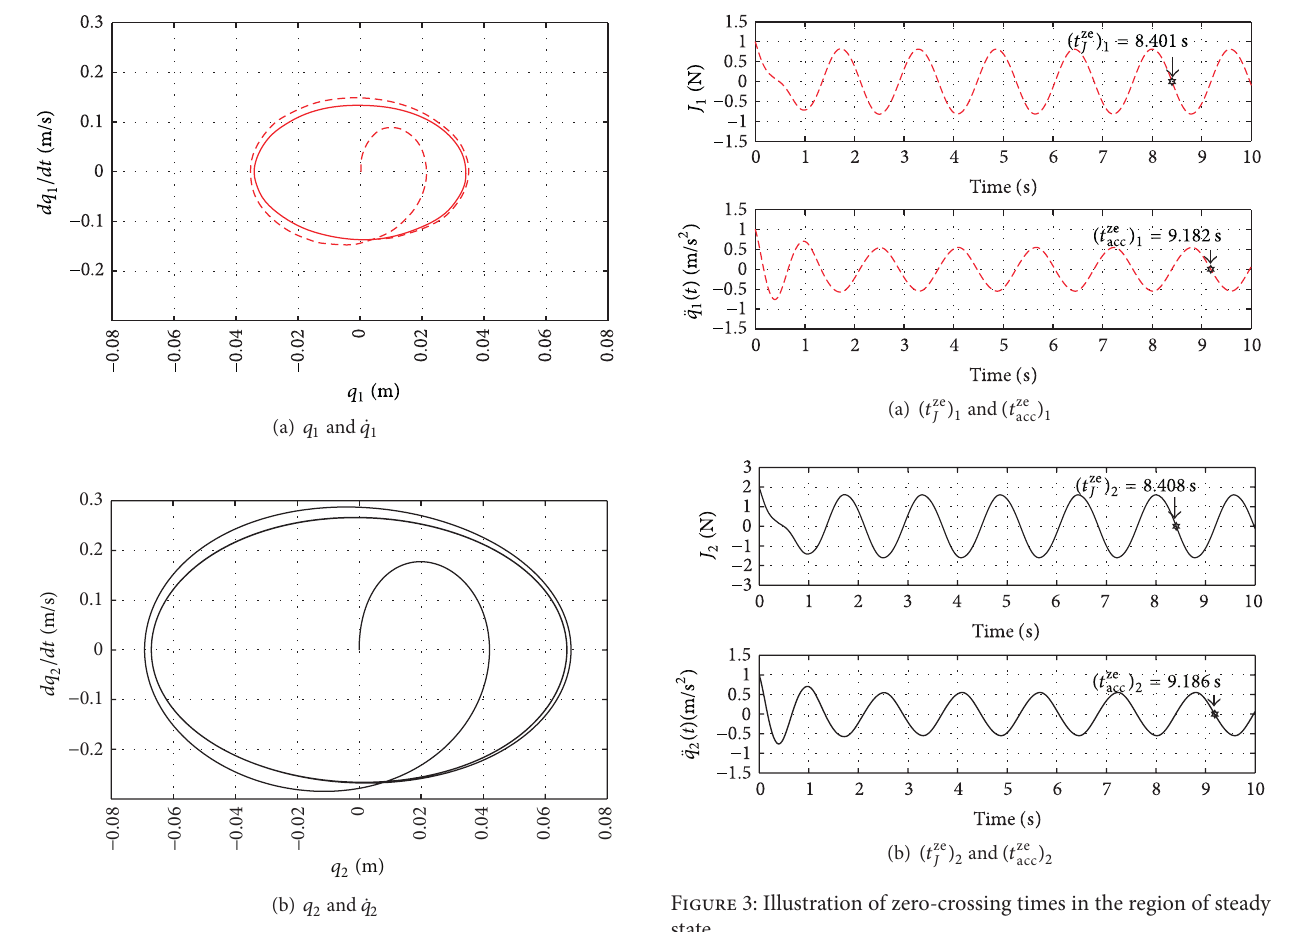
Figure 2: Phase diagrams for the system responses.